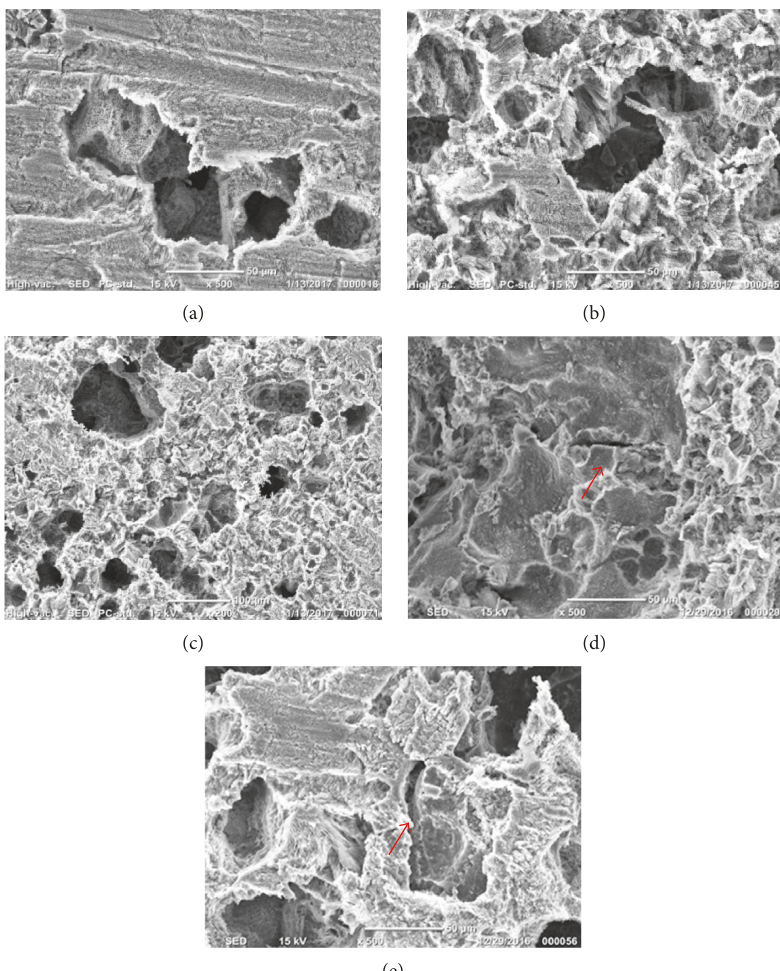
Figure 7: SEM micrographs of the AQ80M bare alloy with different strains: (a) 0.3 σ (d) 0.75 σ 0.2 × 120h, and (e) 0.75 σ 0.2 ×